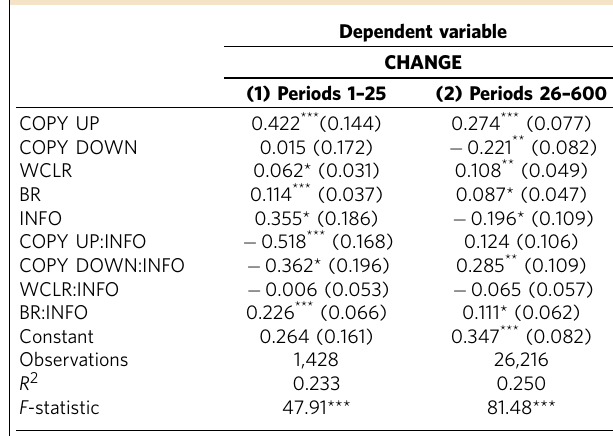
Table 1 | Linear probability model estimates.